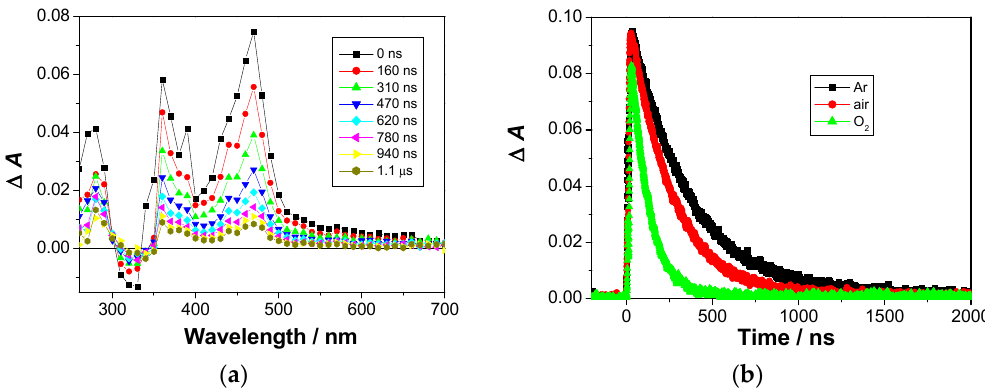
Figure 2. ( a ) Transient absorption spectra of N 2 -purged solution of 1a in CH 3 CN ( c = 7.23 × 10 − 5 M) The samples were excited at 355 nm, laser power ≈ 20 mJ/pulse. ( b ) Decay of transient absorbance at 470 nm in Ar-purged, not purged and O 2 -purged CH 3 CN solution.